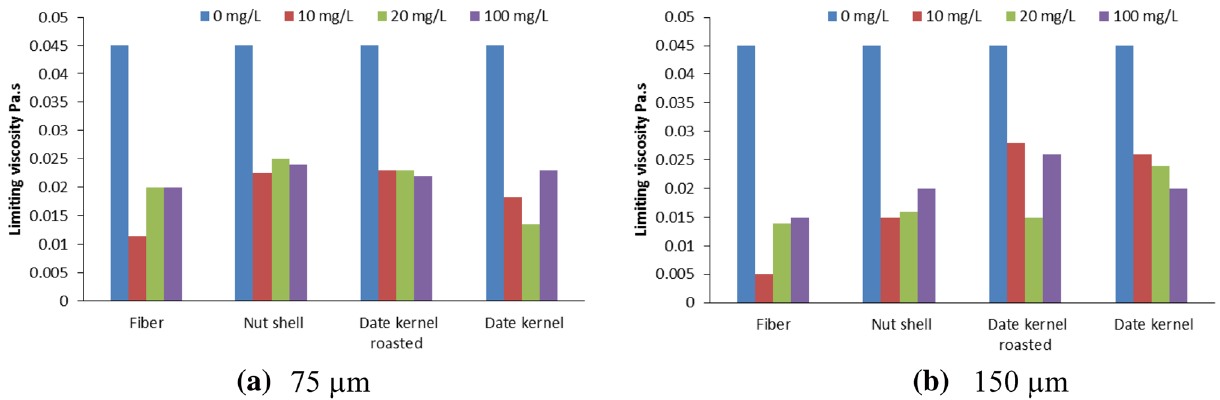
Fig. 5 Limiting viscosity of light crude oil using bio materials